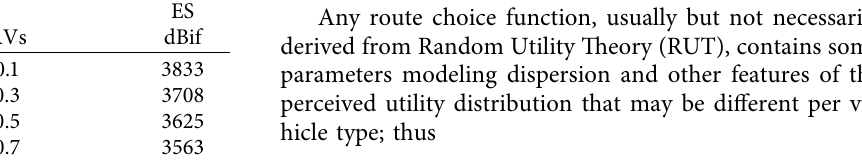
Table 5: Bifurcation demand flow, AVs scenarios B θ θ AV � 2.3 Scenario θ TV � 7.0 θ AV �